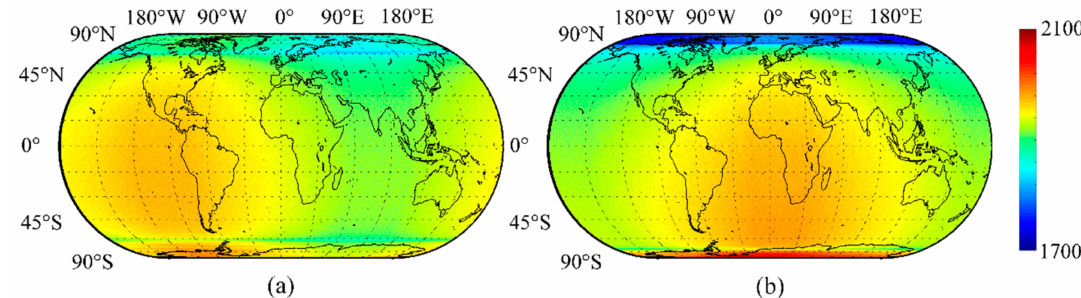
Figure 4. Distribution of the global sampling during the orbital period. The duration is set at the orbital period of ( a ) the maximum and ( b ) the minimum latitudinal range of the nadir point.